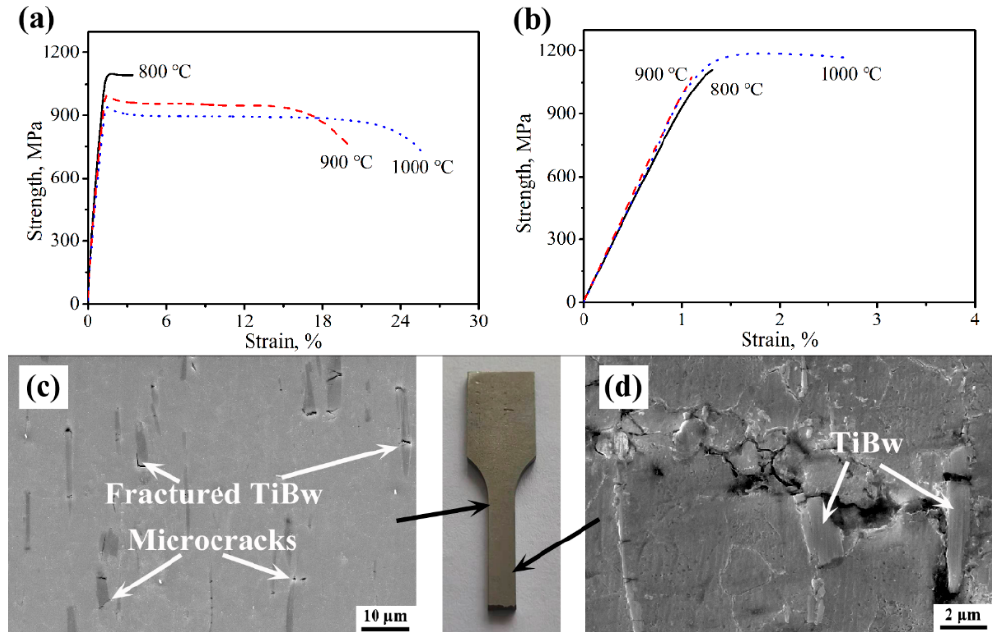
Figure 5. Room temperature tensile curves of ( a ) alloys extruded at 800, 900 and 1000 °C, ( b ) composites extruded at 800, 900 and 1000 °C; SEM of the longitudinal sections of the tensile test specimen of composites extruded at 1000 °C far away from the fracture surface ( c ), near the fracture surface ( d ). During a tensile test for composites, the stress transfers from the matrix to TiBw due to inharmonious deformation, resulting in strengthening [27]. The findings for the composites extruded ◦ at 1000 C will be discussed in the following in more detail and in Figure 5c,d [5]. Massive fractured TiBw and microcracks around TiBw were shown in the SEM image (Figure 5c) far away from the fracture surface., and the crack path included lots of cracks along TiBw and β grains boundaries in the SEM image (Figure 5d) near the fracture surface. These observations indicate that TiBw fractured with the accumulation of load transfer due to the inherent brittleness of TiBw [17], and then, microcracks emerged in the interface of TiBw and matrix. With further deformation, the cracks extended